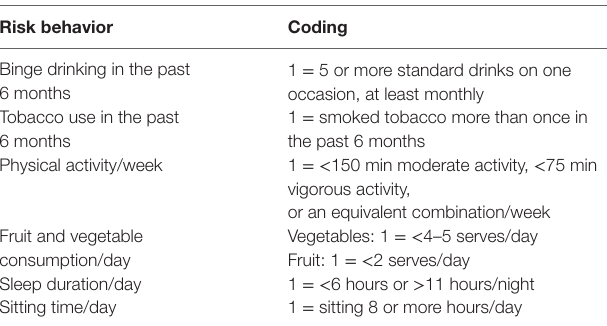
TaBle 1 | Coding of risk behavior